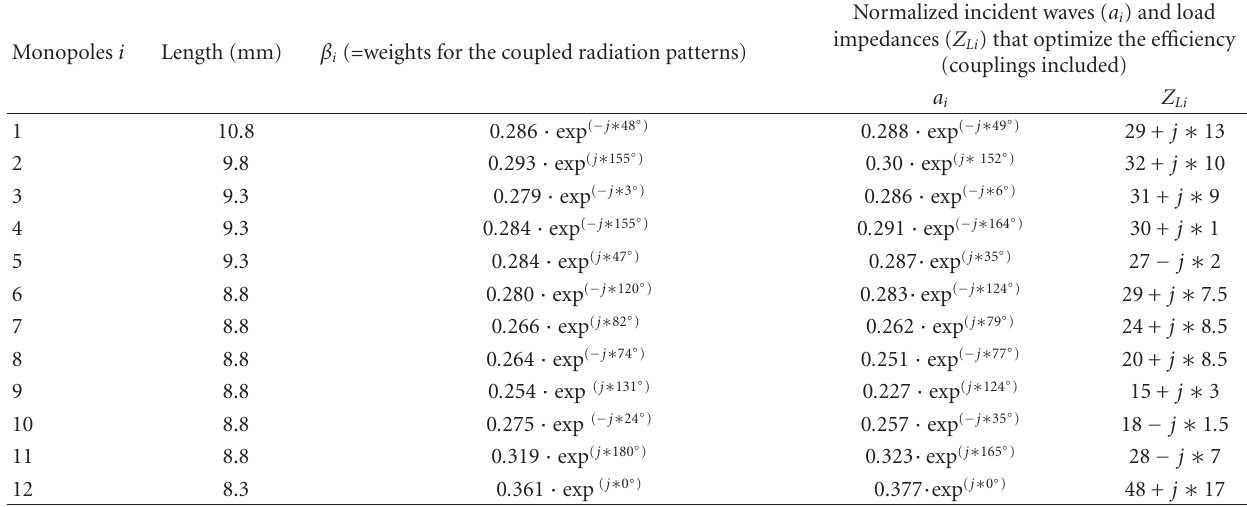
Table 1: Weightings applied to the monopole array and resulting antenna impedances.